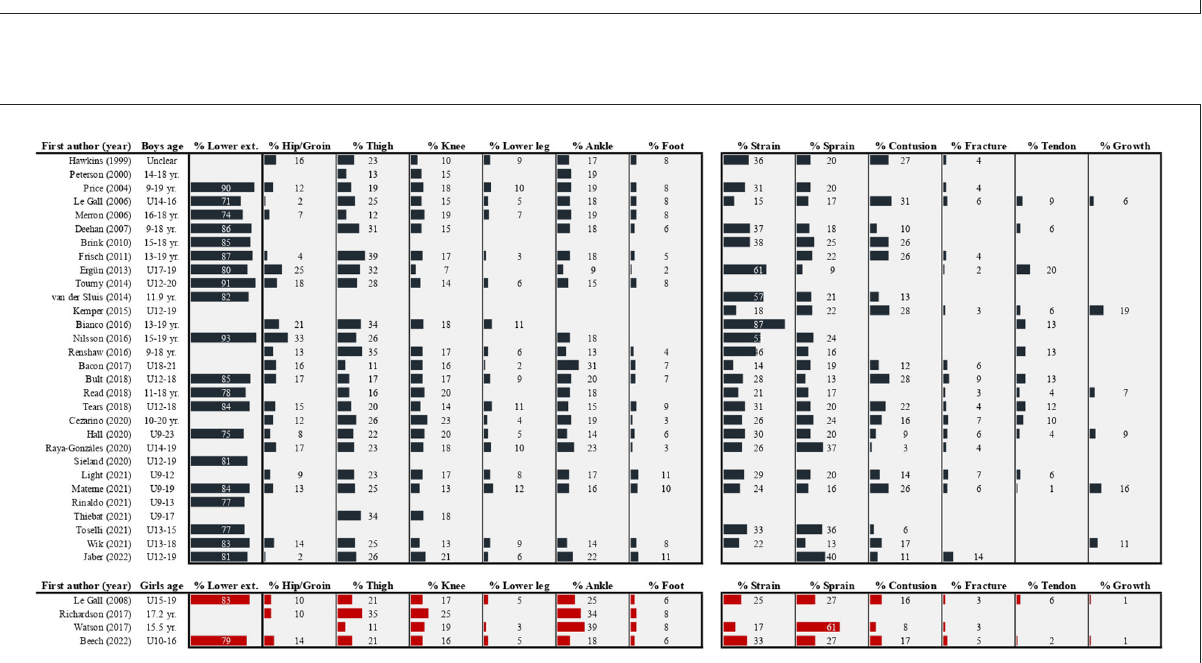
FIGURE2 Reported injury proportions within location and type categories in high-level youth football players. Not all studies used the same classifications, and a best effort was made to place injuries in the most applicable category. In studies reporting subgroup proportions without values for the full sample, the average was entered to give an idea of the overall pattern. Where multiple studies were published with the same or overlapping dataset, only the main epidemiological paper was